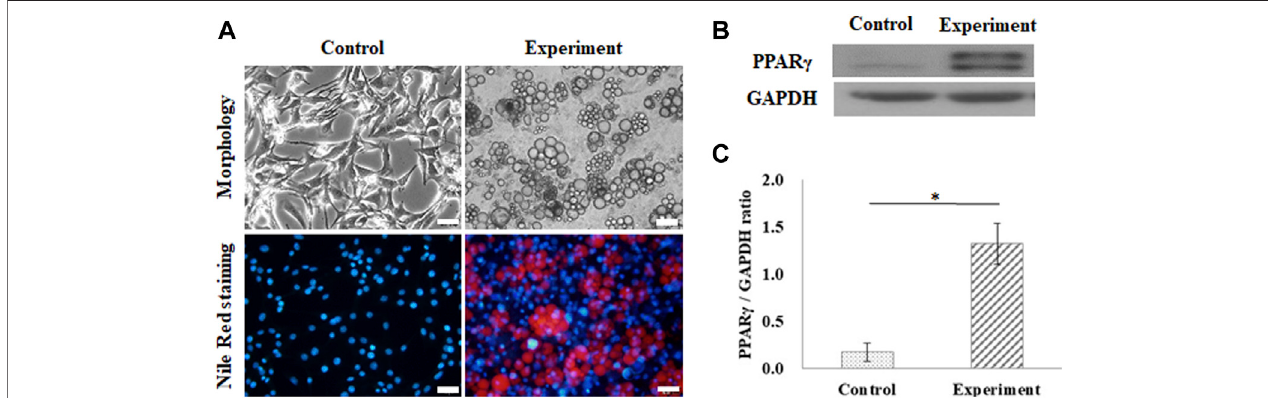
FIGURE 3 | Adipogenic differentiation on the fl at GS-scaffold. (A) The morphology and Nile Red staining of the differentiated 3T3-L1 cells after 10 days induction (scale bar = 50 μ m). (B) The western blots of PPAR- γ and GAPDH. (C) The quanti fi cation of the PPAR- γ expression via the ratio to GAPDH using ImageJ software. The control group comprised cells cultured in the growth medium. Data are presented as the mean ± SD, n = 3, in three independent experiments, * p < 0.05.